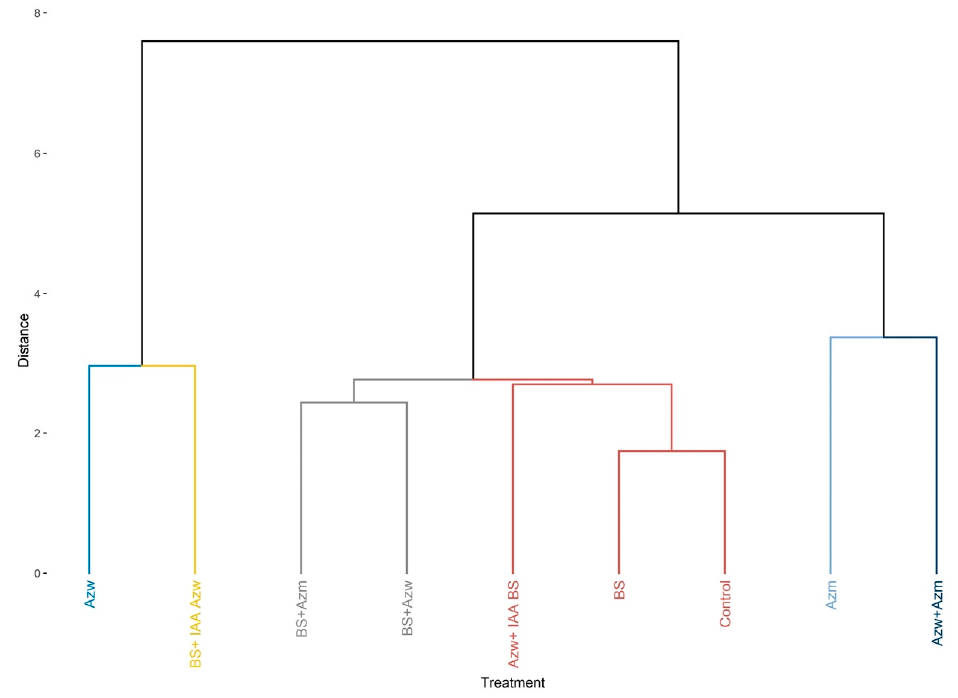
Figure 9. Hierarchical clustering of principal components (HCPCs) of inoculations tested.